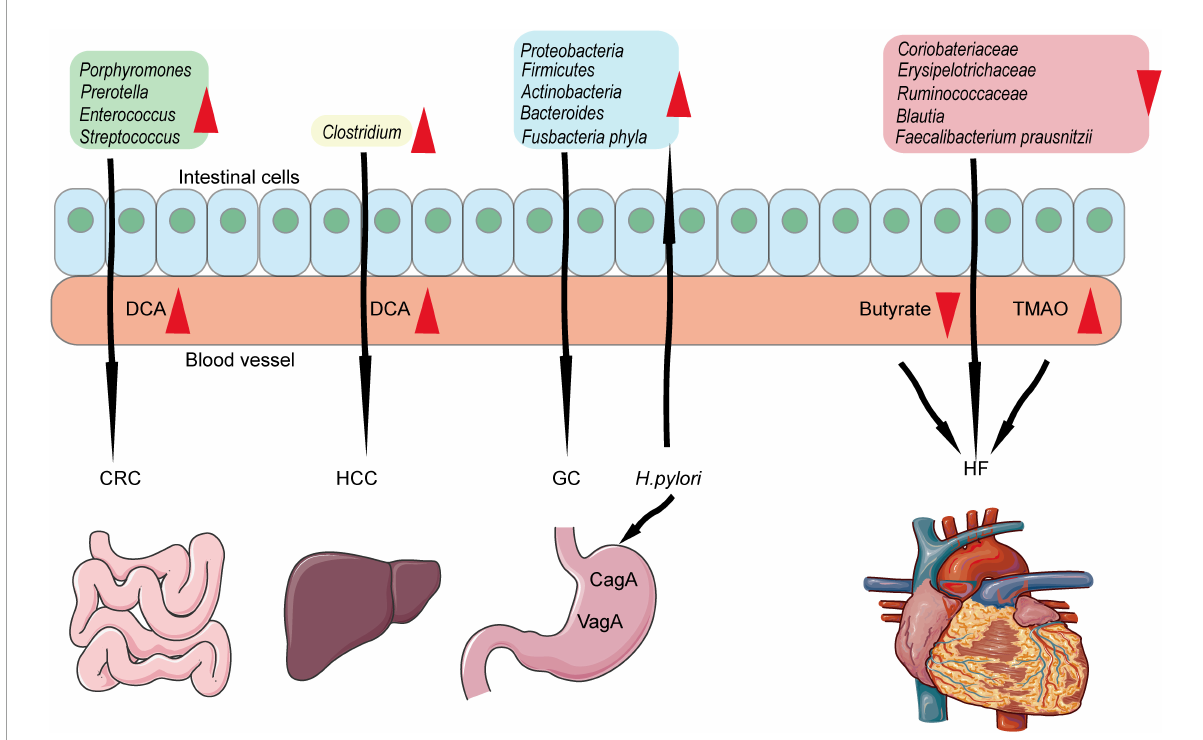
FIGURE3 Associations among gut microbiome, cancers, and heart failure. Porphyromonas, Prevotella, Enterococcus, and Streptococcus increased in intestinal and produced DCA which lead to CRC formation and progression. Clostridium is related to HCC. Proteobacteria, Firmicutes, Actinobacteria, Bacteroides, and Fusobacteriaphyla are related to GC. Besides, Helicobacter pylori could induce GC-related gut microbiome which in turn lead to GC. Coriobacteriaceae, Erysipelotrichaceae, Ruminococcaceae, Blautia, and Faecalibacterium are related to heart failure by producing TMAO and decreasing